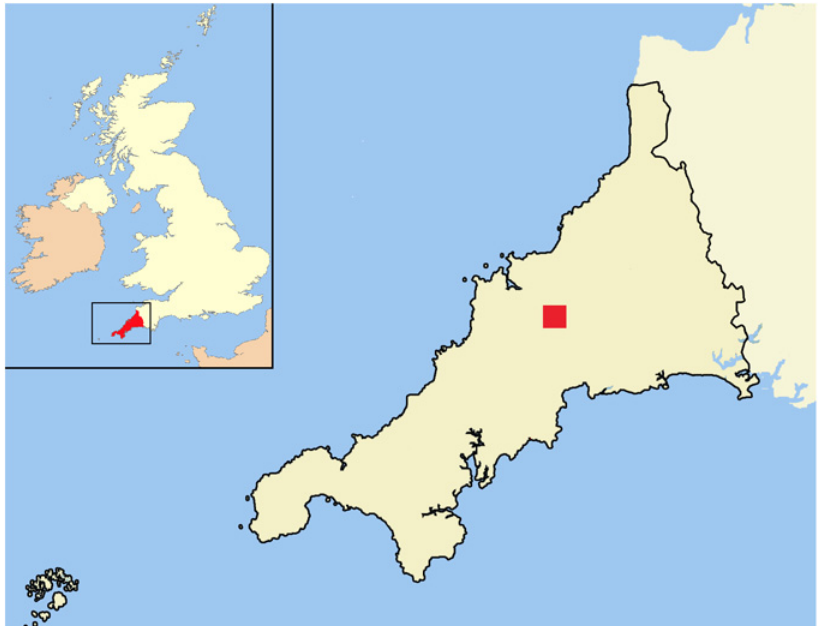
Fig 1. Location of 5x5 km study site within Cornwall in south-west